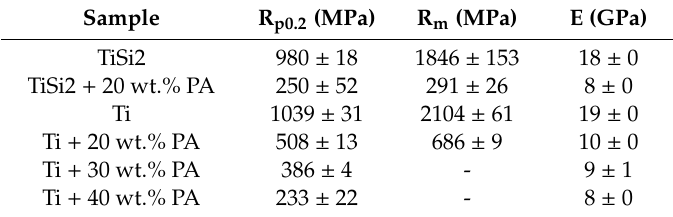
Table 2. Mechanical properties obtained from compressive stress–strain